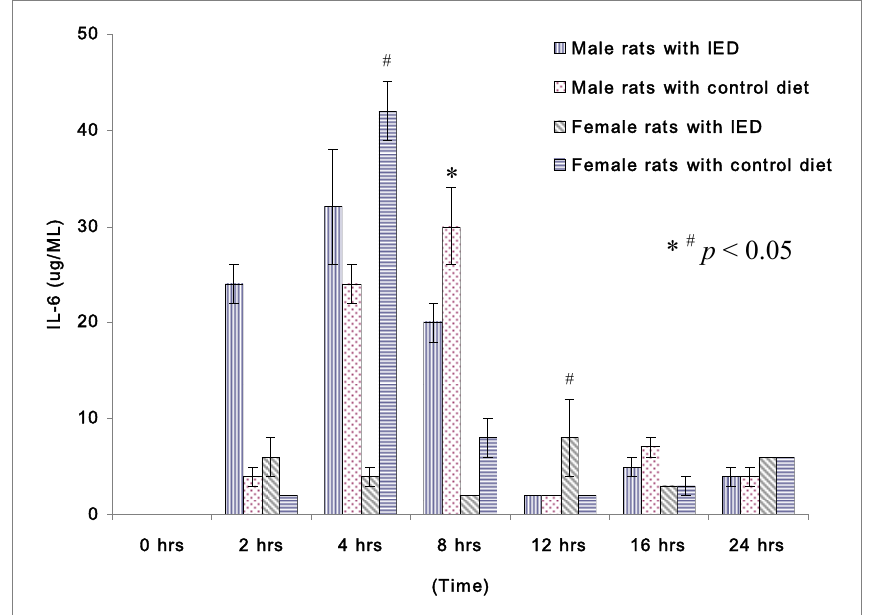
Figure 2. Plasma concentrations of IL- β ( μ g/mL) in rats at 0, 2, 4, 8, 12, 16, and 24 h after CLP in cirrhotic female rats fed with control diet ( n = 28), cirrhotic female rats fed with immune enhancing diet ( n = 28), cirrhotic male rats fed control diet ( n = 23), and cirrhotic male rats fed with immune enhancing diet ( n = 23). * p < 0.05 between male rats; # p < 0.05 between female rats; IL-6, interleukin-6. The data are expressed as Mean ±